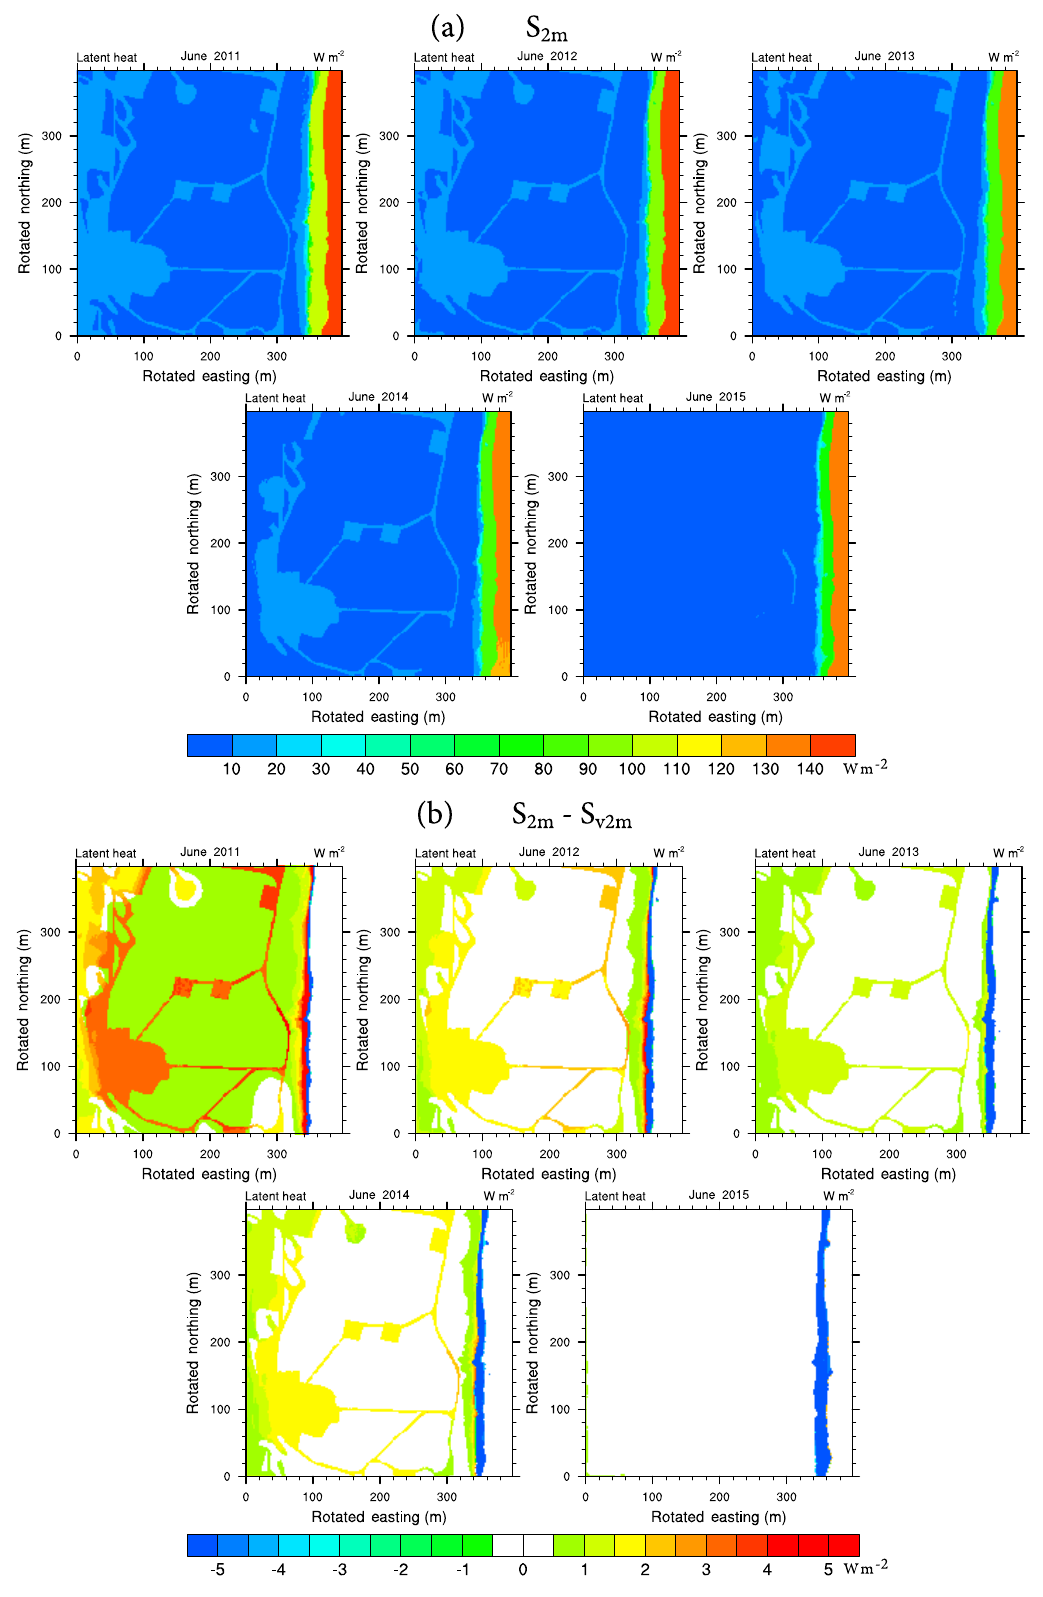
Figure 8. (a) Simulated latent heat fluxes in June from the three-dimensional simulation ( S 2m ) and (b) the difference between the three- dimensional and vertical-only simulations (i.e., S 2m − S v2m )